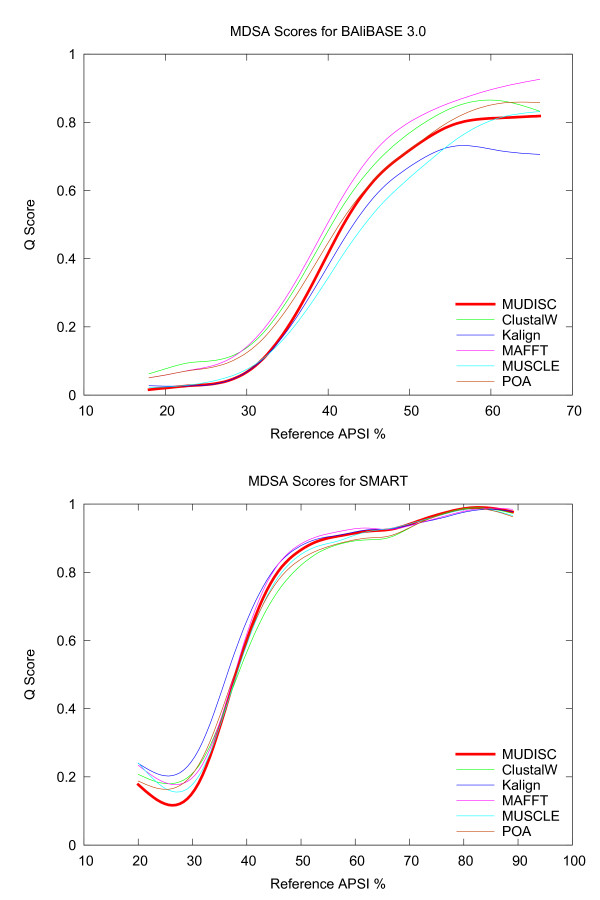
Alignment quality on the MDSA data set. MUDISC (the new method) is compared with several alignment programs on the MDSA data set which contains nucleotide adaptations of the BAliBASE and SMART reference alignments. BAliBASE includes reference sets 1-7. MUDISC uses discrete profile alignment.